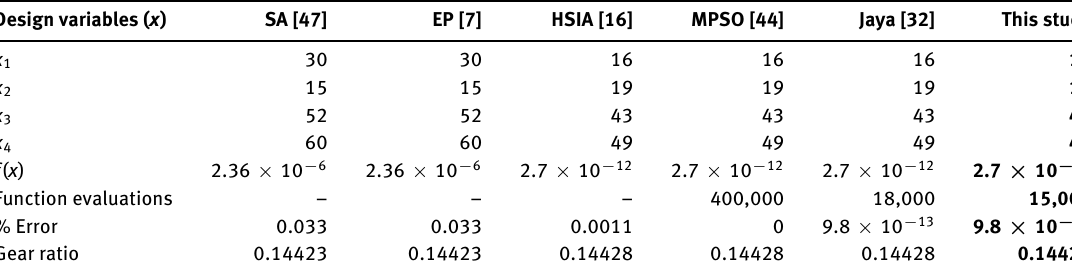
Table 5: Optimal Design for the Compound Gear Train. Design variables ( x )